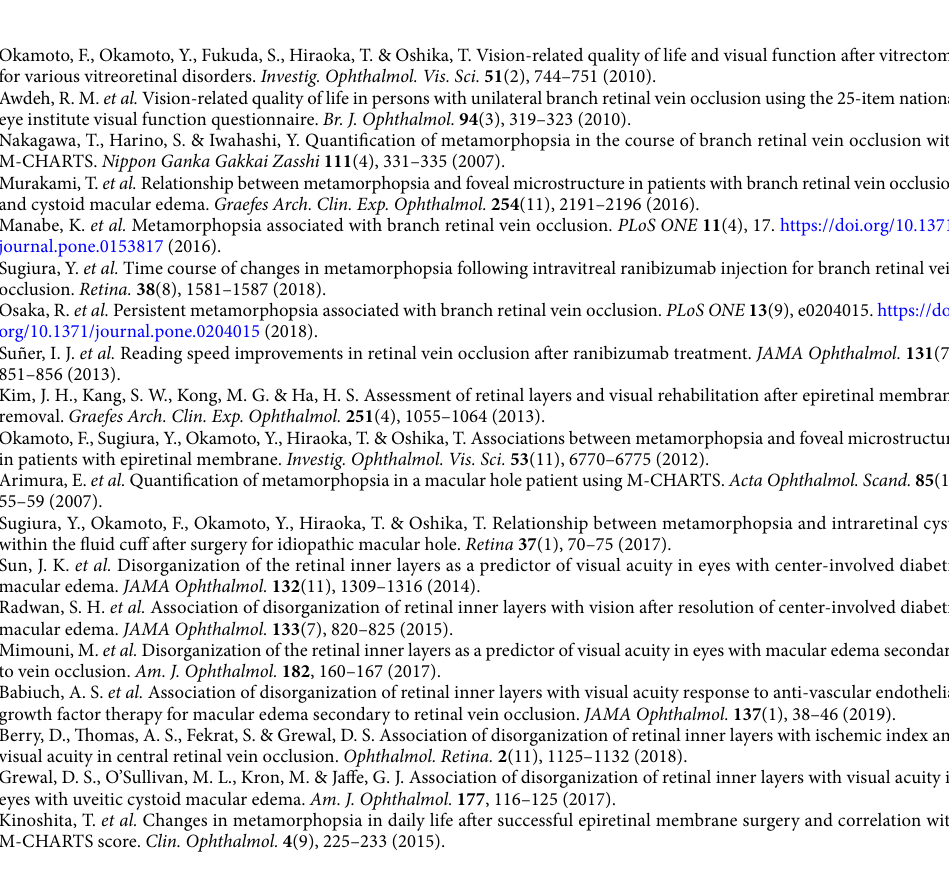
Figure 4. We assessed disorganization of the retinal inner layers (DRIL) at the first month after resolution of the macular edema (early DRIL) within the region of 6 mm in diameter centered on the fovea. The length of DRIL after treatment was also measured on all patients with a resolved macular edema at 12 months or around 12